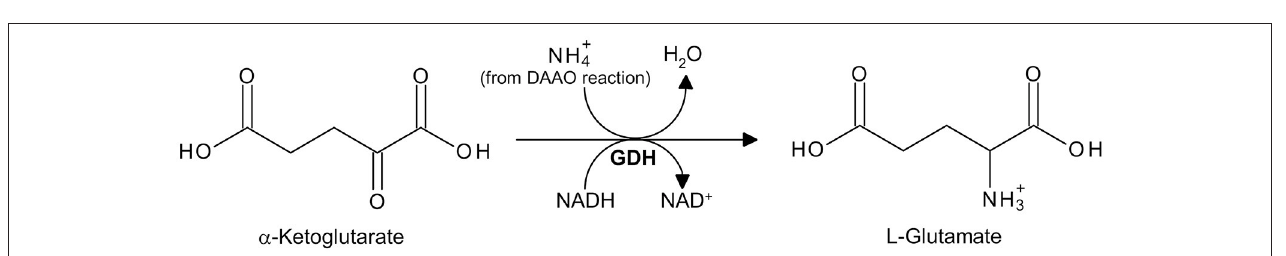
FIGURE 5 | Detection of ammonium produced by DAAO in a GDH-coupled reaction using α -ketoglutarate.